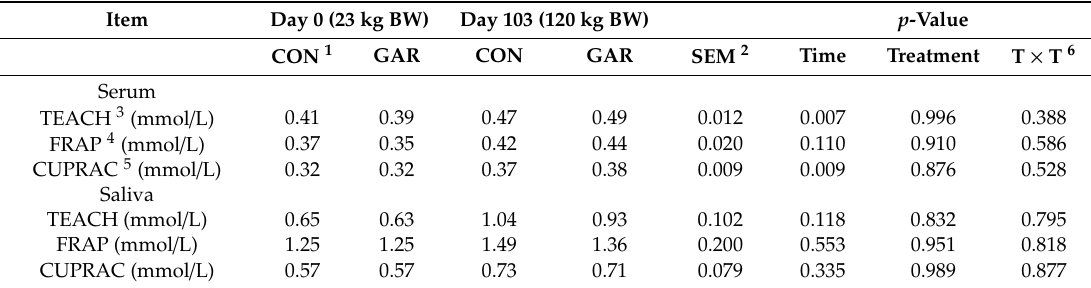
Table 7. The e ff ect of sampling time and dietary treatment on serum and saliva antioxidant capacity in